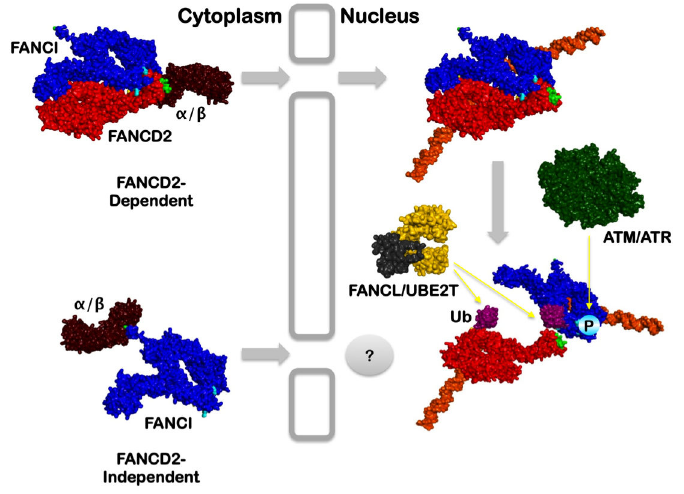
Figure 6. FANCD2-dependent and -independent mechanisms of FANCI nuclear localization. We propose that a subset of FANCI (blue) associates with FANCD2 (red) in the cytoplasm, and that the ID2 heterodimer is transported to the nucleus via an importin α/β (brown)-mediated transport mechanism, using the amino terminal FANCD2 NLS (light green). Nuclear ID2 binds to DNA (orange) and is also phosphorylated by the ATM/ATR kinases (dark green). One or both of these events may trigger ID2 complex restructuring, facilitating FANCD2 and FANCI monoubiquitination by FANCL (black), UBE2T (yellow) and the FA core complex (not